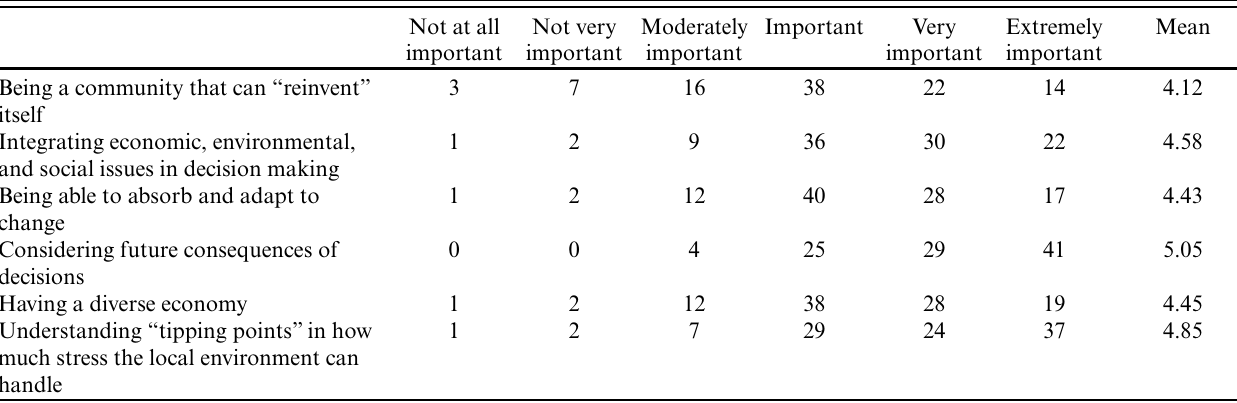
Table 2 . Importance of sustainability and resilience to community future. “How important do you think the following are to a positive future for communities like yours?” Please check one per row.